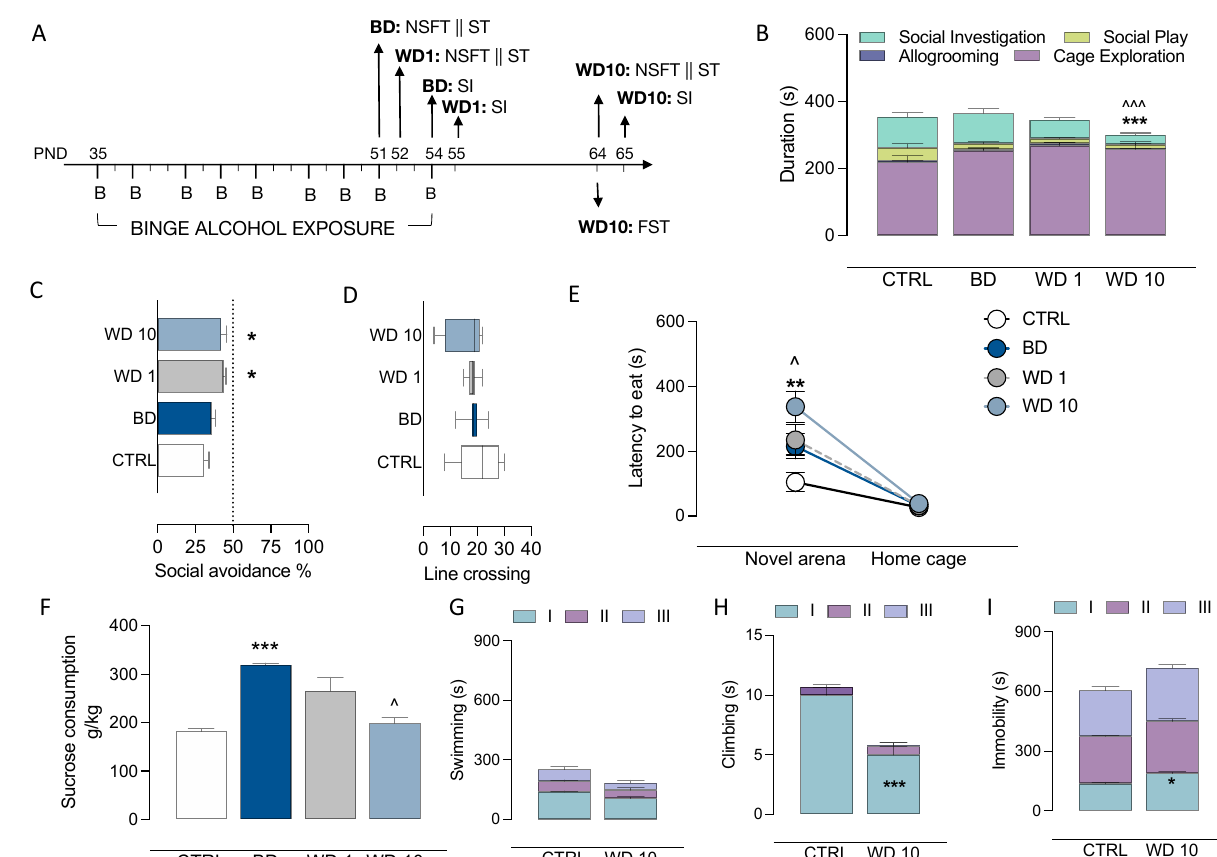
Figure 1. Binge-like alcohol exposure during adolescence disrupts reward/aversion behaviour during withdrawal. ( A ) Rats exposed to a binge-like alcohol drinking paradigm during adolescence did not show social behaviour alterations at BD, whereas they displayed ( B ) decreased duration of social investigation at WD10, as compared with CTRL (*** p < 0.001) and BD (ˆˆˆ p < 0.001) and ( C ) increased social anxiety-like behaviour, in terms of social avoidance %, at WD1 and WD10, when compared with CTRL ( * p < 0.05) ( D ) in the presence of no difference in the number of line crossings, as a measure of locomotor activity. In addition, ( E ) rats exposed to a binge-like alcohol drinking paradigm during adolescence did not show novelty-induced anxiety-like behaviour in the novelty-suppressed feeding test at BD, since no difference in latency to eat in the novel arena was measured with respect to CTRL, while, at WD10, they show increased latency to eat when compared with CTRL (** p < 0.01) and BD (ˆ p < 0.05), who showed no difference in latency to eat in their home cage. On the other hand, ( F ) at BD rats showed increased sensitivity to natural reward in the sucrose-preference test as compared with CTRL rats (*** p < 0.001), which significantly decreased at WD10 (ˆ p < 0.05). ( G – I ) When tested for coping under forced-swim stress, Rats exposed a to binge-like alcohol drinking during adolescence showed ( G ) similar swimming duration as CTRL rats, however, WD10 rats displayed a passive coping strategy withing the first 5 min of the test, wherein we observed ( H ) decreased climbing and ( I ) increased immobility duration, as compared with the CTRL counterpart. BD: binge day;